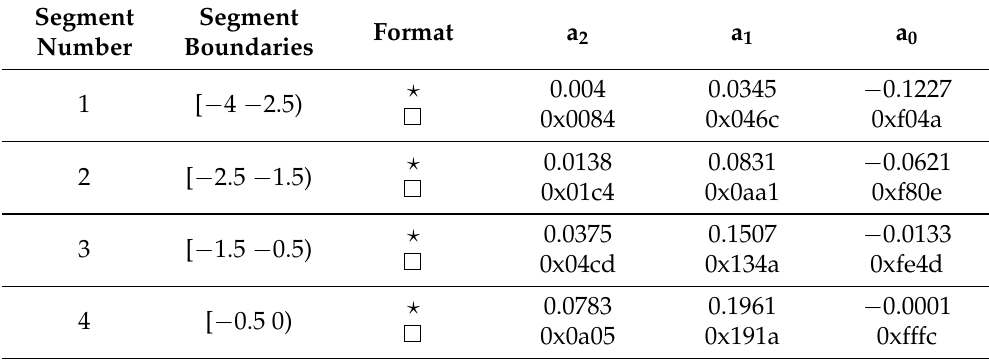
Table 7. Floating-point and fixed-point coefficients for implementing ELU AF in HNN.